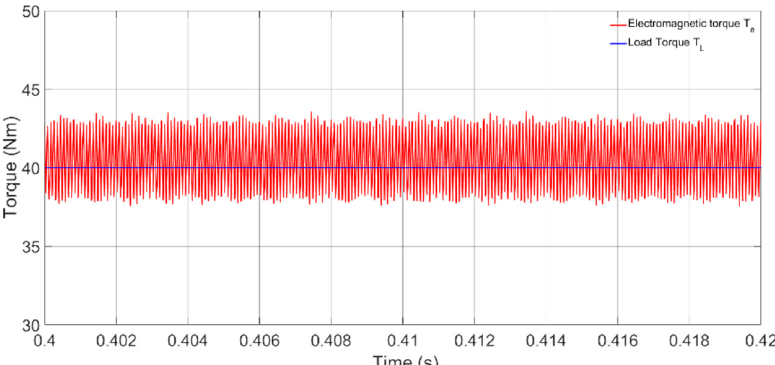
Figure 7. Torque waveform with 40 Nm for cSVM-DTC2 (11 kHz).